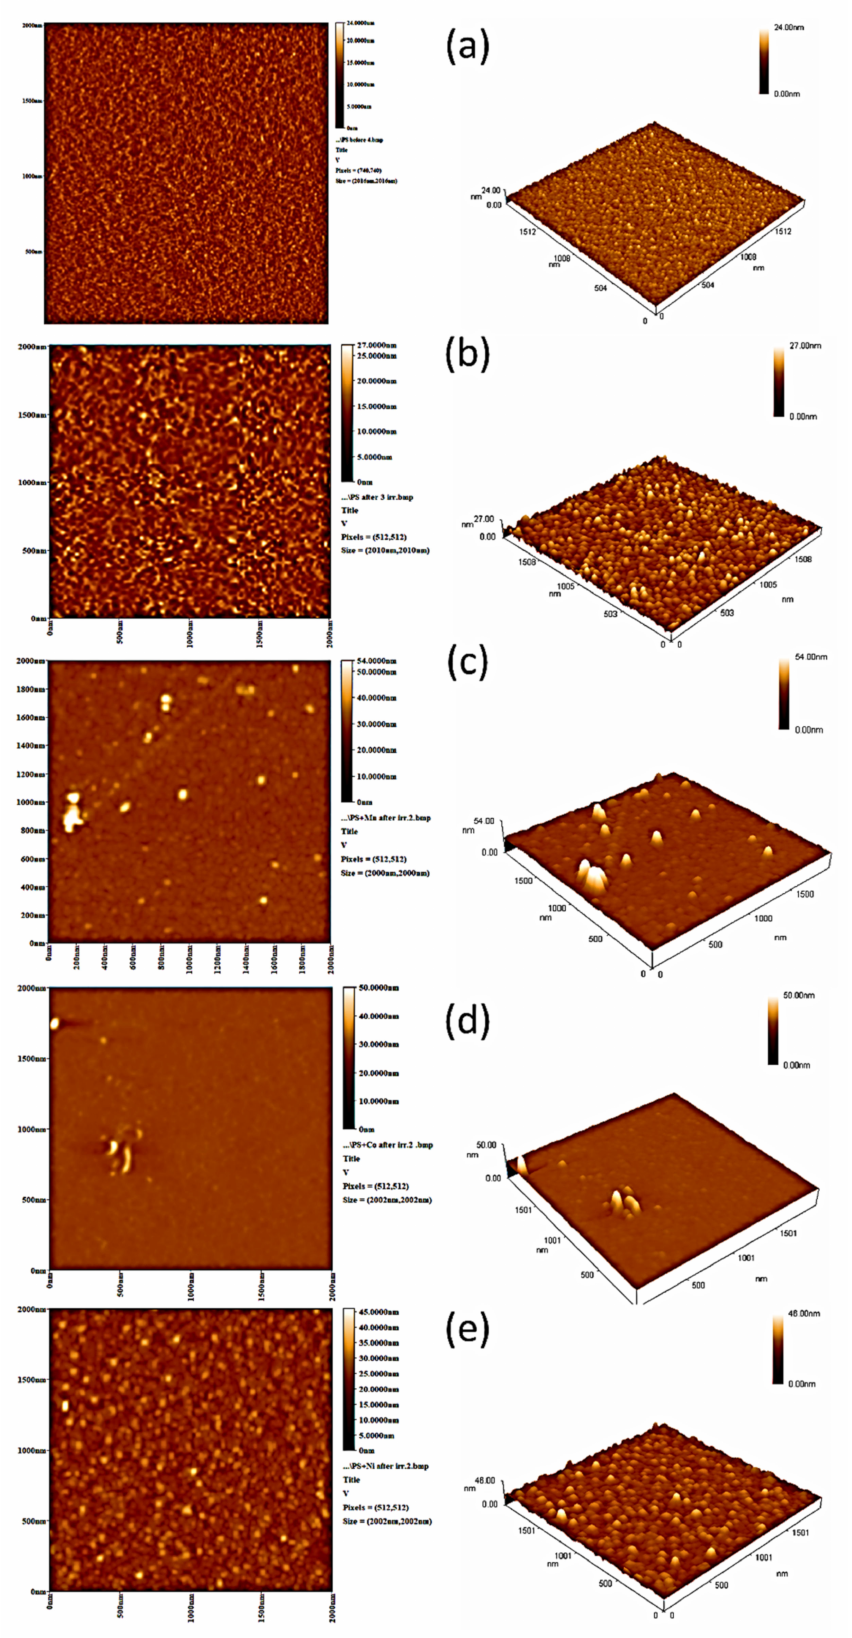
Figure 9. AFM images of ( a ) PS film before irradiation and after irradiation of ( b ) pure PS film, ( c ) PS + ibuprofen–Mn complex, ( d ) PS + ibuprofen–Co complex, and ( e ) PS + ibuprofen–Ni